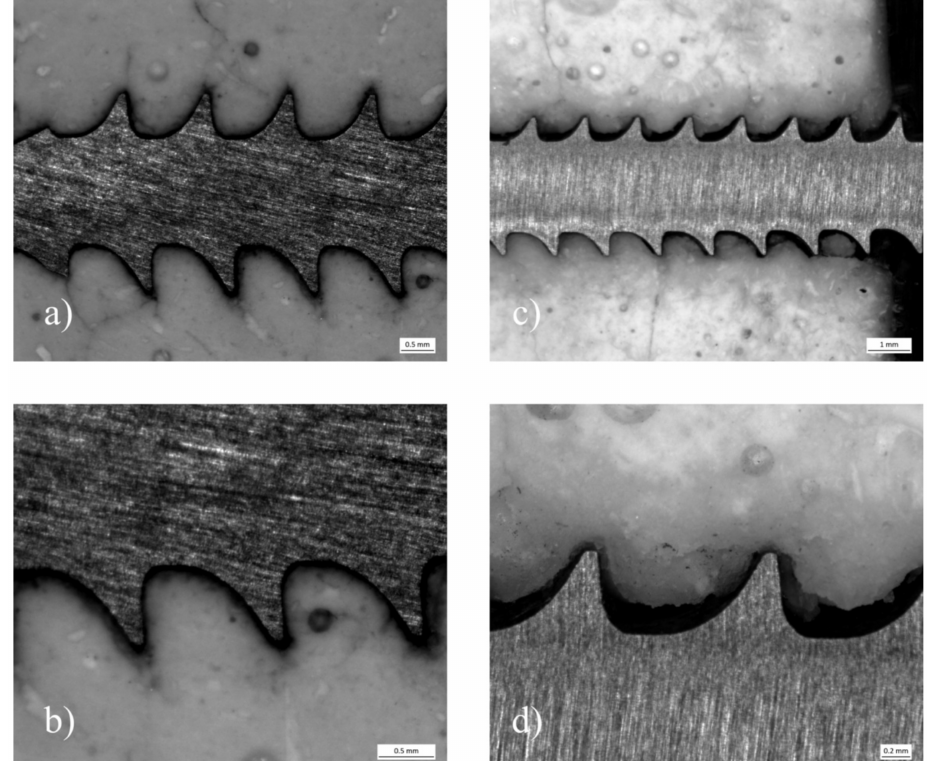
Figure 12. Stereomicroscope images of pullout specimens made of MPC_25 with embedded and drilled screws: ( a ) Depicts a specimen, where the screw was embedded. The cement mantle seams to interdigitate seamlessly into the screw threads. At a close-up view ( b ) only a small gap can be distinguished contrary to ( c , d ), where a screw was manually inserted after drilling and tapping.